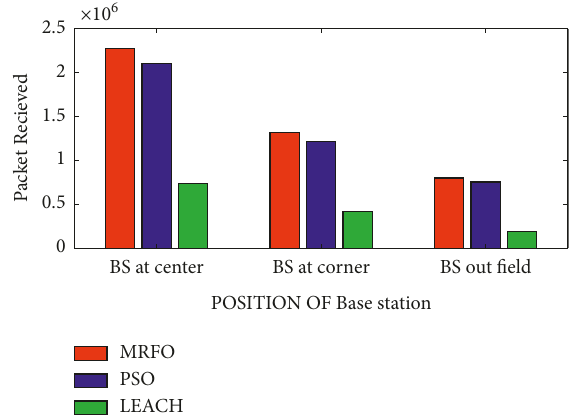
Figure 21: Number of packets received for 300-node network with 30 CHs.